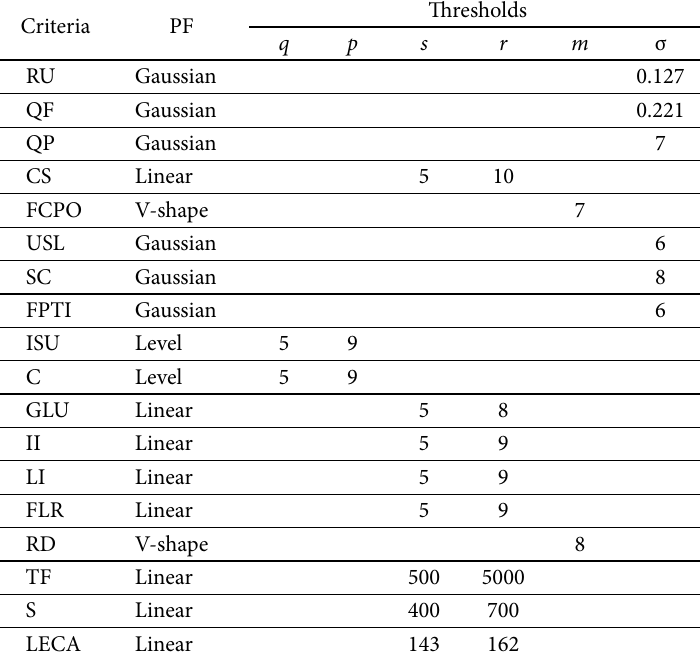
Table 12. Preference